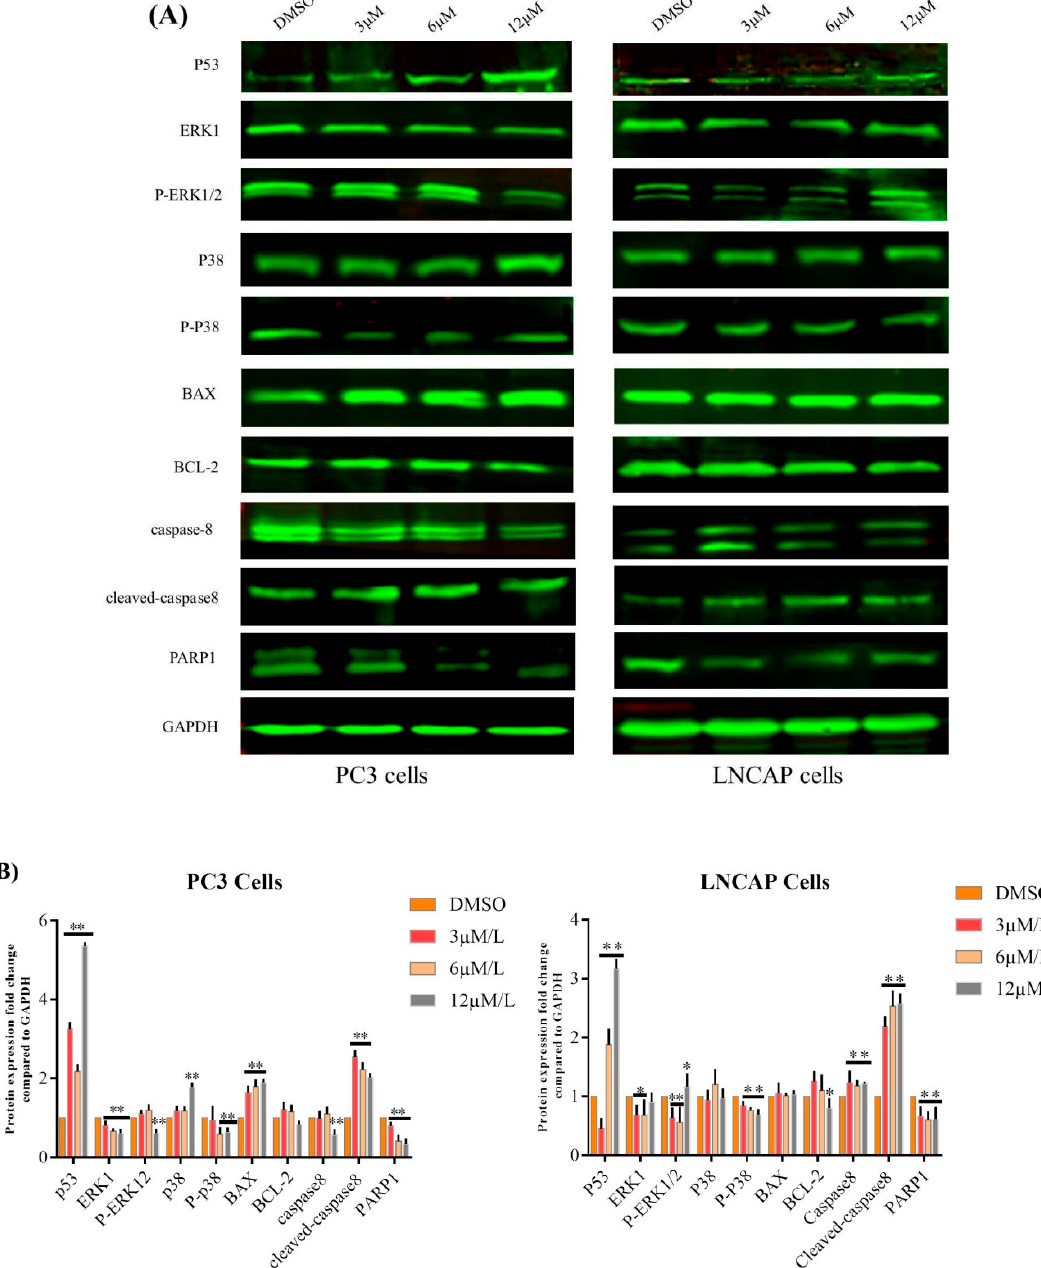
Figure 2. E ff ects of TC7 on apoptotic protein expression in PCa and LNCAP cells. Cells were incubated with TC7 at di ff erent concentrations (3, 6, 12 µ M) for 24 h, then total proteins were extracted. ( A ) The expression of apoptotic proteins was detected using western blot in the cells treated with TC7 . ( B ) Quantitative analysis of the protein expression by Image J software. GAPDH was used as a loading control. Experiments were performed in triplicate. Results are presented as mean ± SEM. * p < 0.05 ( n = 3) compared with the control, ** p < 0.01 ( n = 3) compared with the control.